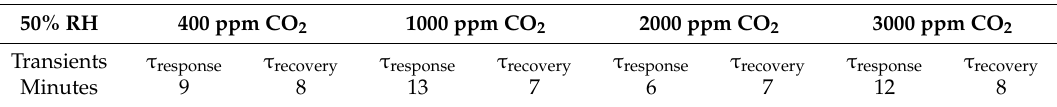
Figure 10. ( a ) Variations in electrical resistance for BSTCo5_800 due to exposure to CO 2 in atmospheres with variable relative humidity (0%, 10%, 30%, and 50% RH); ( b ) The sensor signal for 400–3000 ppm of CO 2 under di ff erent relative humidity background conditions. Table 4. Calculated response and recovery times related to the changes in the electrical resistance upon di ff erent CO 2 concentration exposure as presented in Figure 10a.